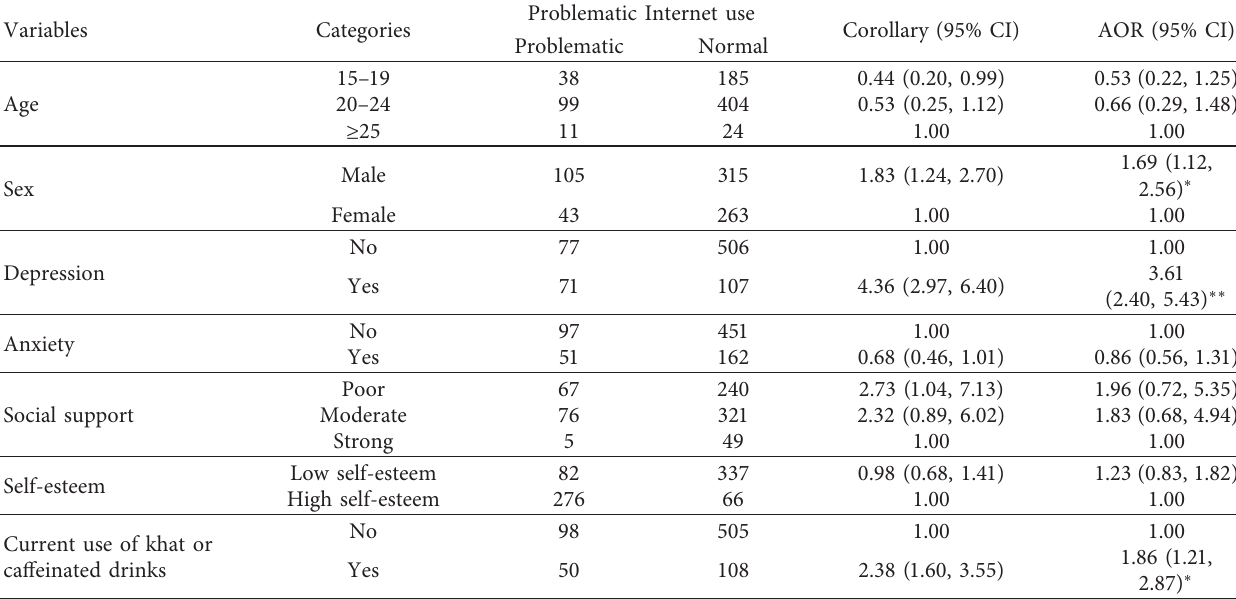
Table 4: Factors associated with problematic Internet use among undergraduate students (bivariate and multivariate analysis) ( n � 761), Dilla, Ethiopia, in